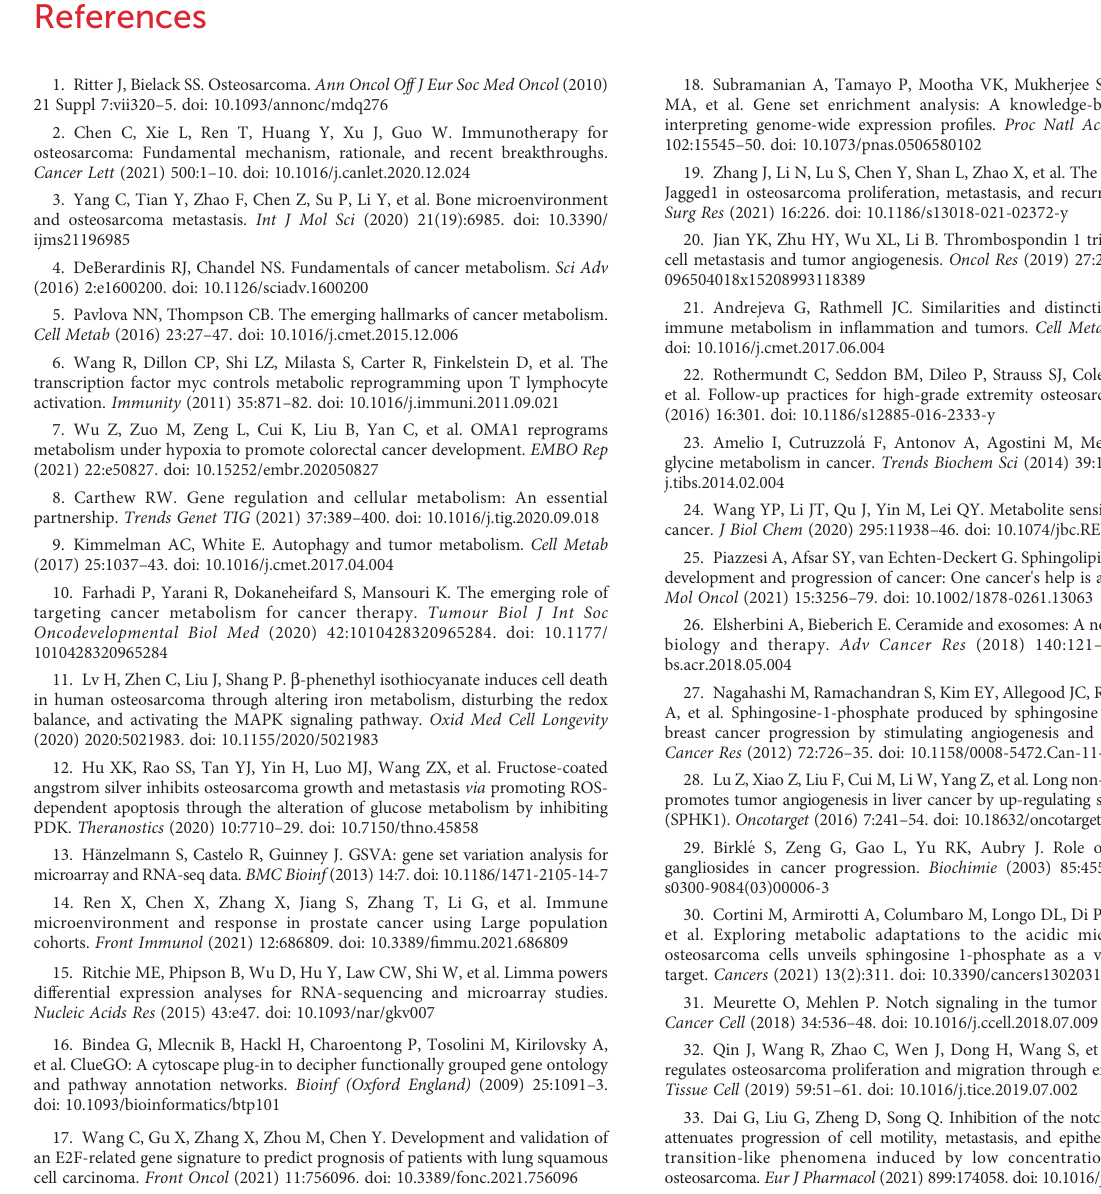
SUPPLEMENTARY FIGURE 2 Notch signaling and angiogenesis in metastatic and non-metastatic OS (A) :ThepathwayactivitydifferenceofNotchsignalingandangiogenesisin metastatic and non-metastatic OS; (B) : Angiogenesis-related genes in metastatic and non-metastatic OS; (C) : Notch signaling-related genes in metastatic and non-metastatic OS. SUPPLEMENTARY FIGURE 3 Disease-free survival difference of our model (A) : Kaplan-Meier survival curve of disease-free survival; (B) : ROC curves of 1-, 3- and 5-years disease-free survival. SUPPLEMENTARY FIGURE 4 GO and KEGG analysis of our model (A) : KEGG analysis of our model; (B) : GO analysis of our